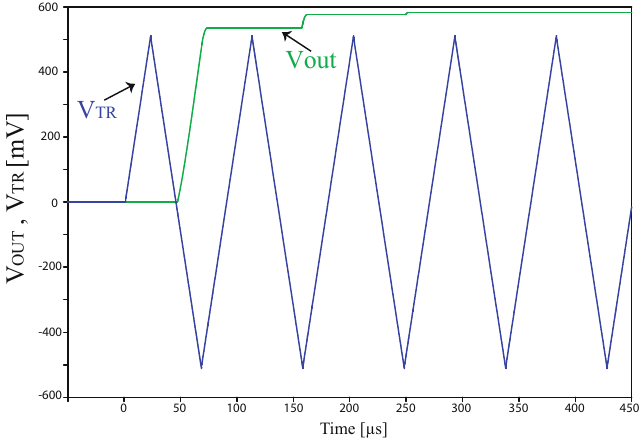
Figure 5. V out and V TR as a function of the time, for C sensor = 30 pF.